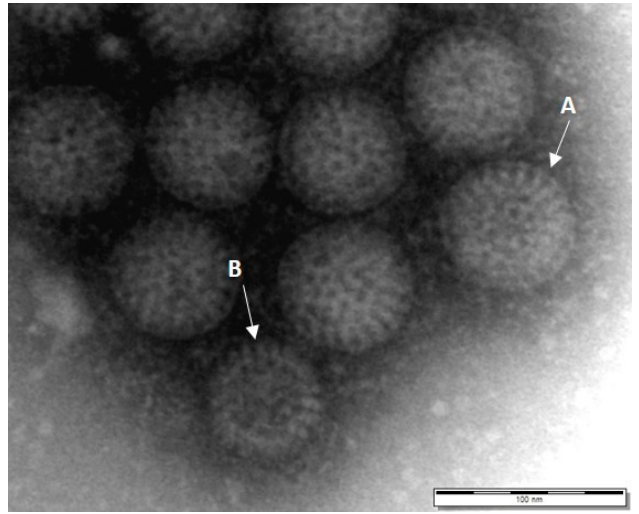
Figure 4. Rotavirus particles using electron microscopy. ( A ) intact virus particles; ( B ) Virus particles without an outer protein layer (scale bar: 100 nm, image, CVUA-Stuttgart).